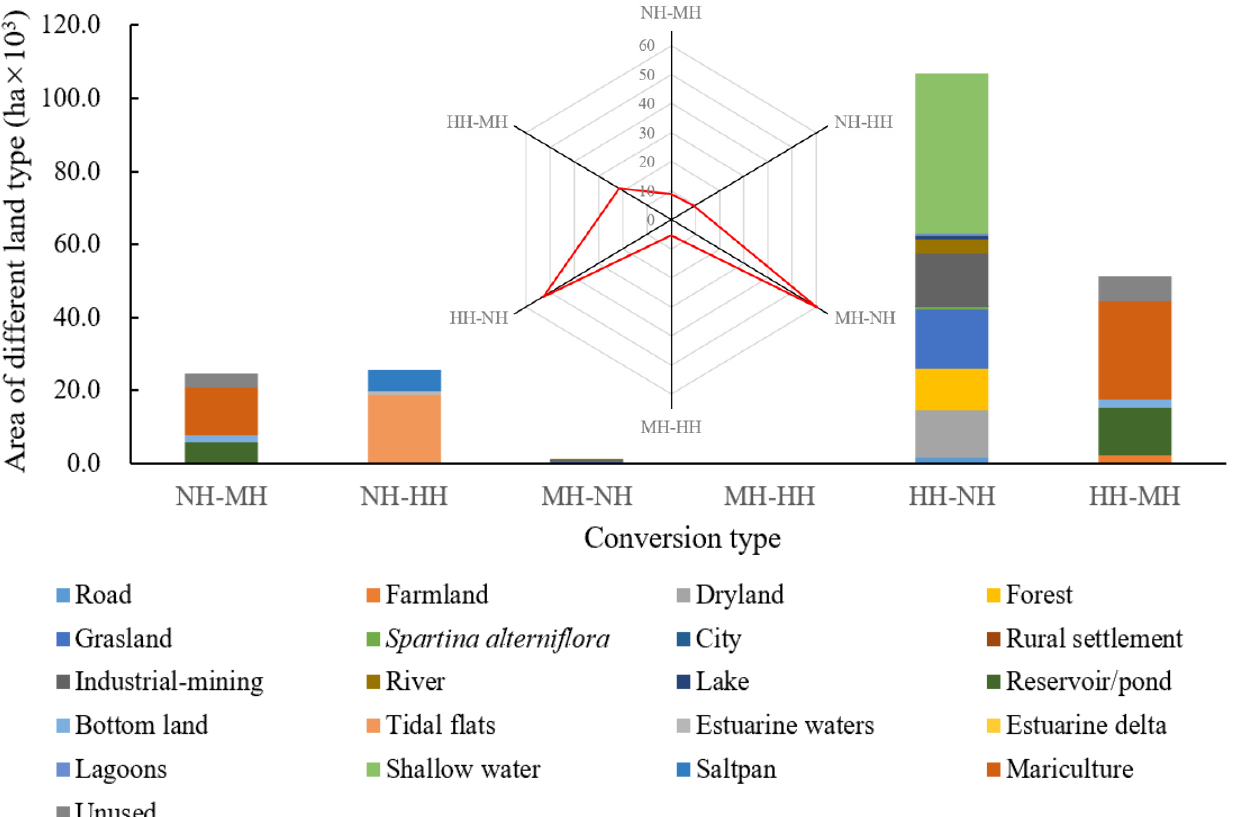
Figure 4. Conversion ratio between different habitat quality categories and causes of habitat conversion. Non-habitat (NH), medium- and low-quality habitat (MH), and high-quality habitat (HH).